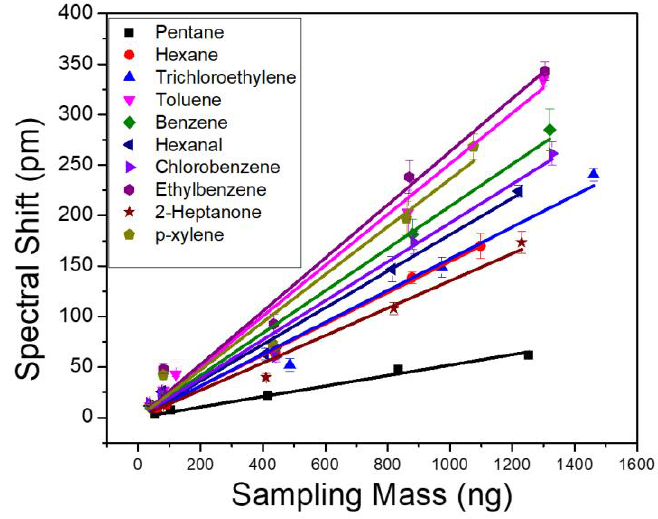
Figure 4. PCS sensor spectral shift obtained as a function of sampling mass for 10 VOCs. All analytes are measured with the same column temperature ramping profile and a flow rate of 1 mL/min.